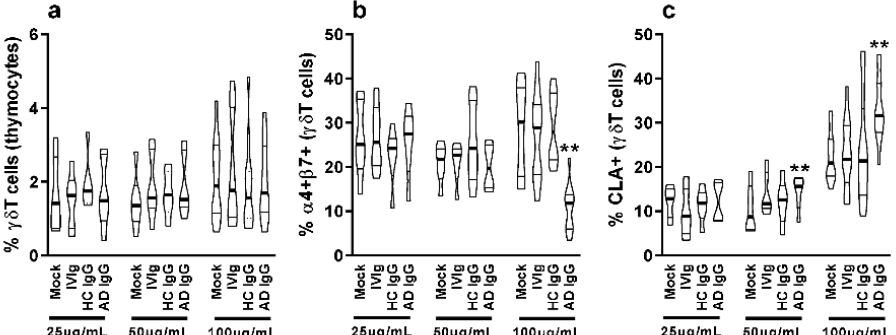
Figure 1. Purified adult AD IgG’s effect on the homing phenotype of infant nonatopic intra- thymic γδ T cells. Thymocytes from children under 7 days old ( n = 12) were evaluated after 6 days in culture in RPMI medium supplemented with FCS in the absence (mock) or presence of 25, 50, or 100 µ g/mL of commercially used purified IgG (IVIg), or IgG purified from health controls (HC IgG) or IgG purified from adult AD patients (AD IgG). Flow cytometry was used to determine the frequency of γδ T (CD3+ γδ TCR+) cells ( a ) or the expression of α 4+ β 7+ ( b ) and CLA ( c ) in γδ T (CD3+ γδ TCR+). Violin plots depict the distribution of values from lowest to highest, with thick lines representing quartiles, and bold lines representing the mean. ** p ≤ 0.05 when compared to Mock, IVIg, and HC IgG conditions.